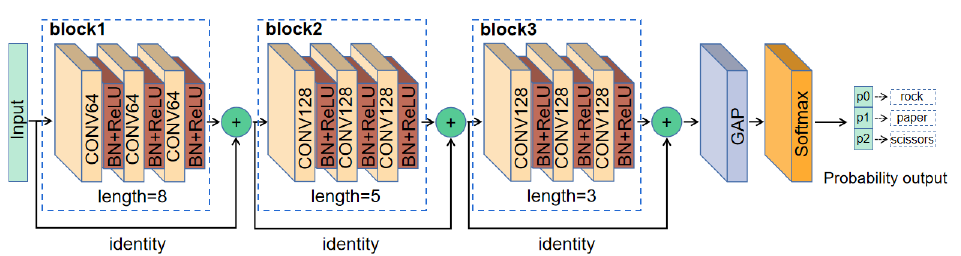
Figure 3. The structure of ResNet.